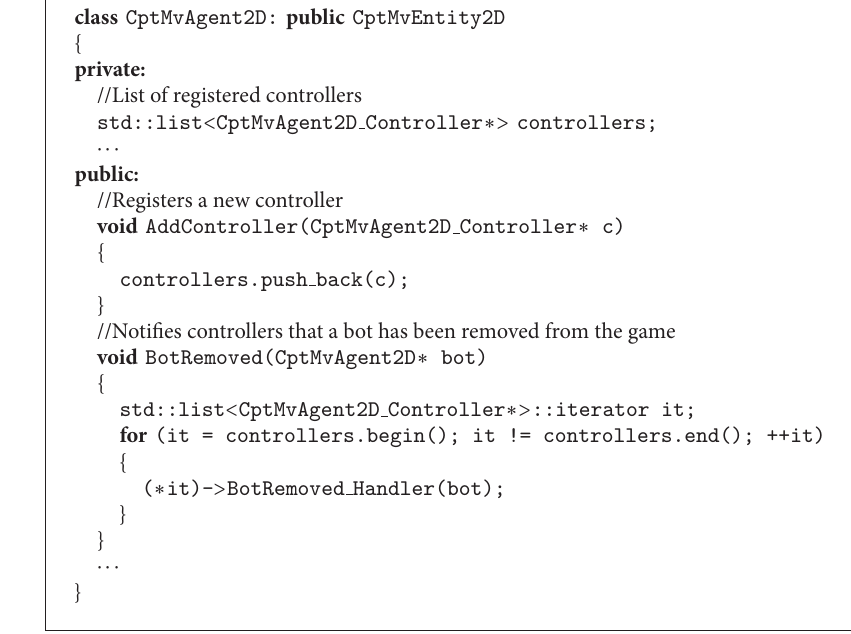
Algorithm 13: Controller management in the CptMvAgent2D